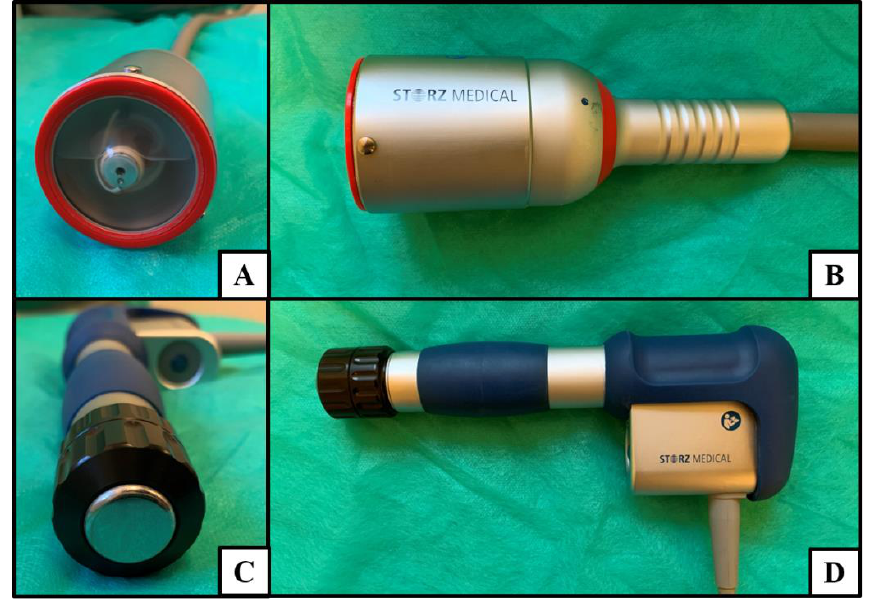
Figure 1. Extracorporeal shock wave applicators: ( A ) front and ( B ) lateral view of focused extracorporeal shock wave therapy (fESWT) (electromagnetic type—EM); ( C ) front and ( D ) lateral view of radial extracorporeal shock wave therapy (rESWT) (pneumatic type—PN).